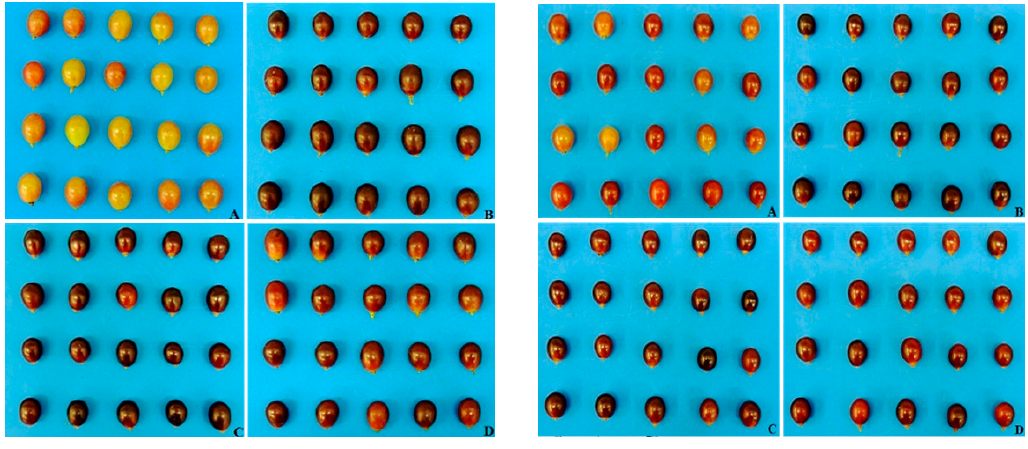
Figure 3. Berries of ‘Benitaka’ table grapes subjected to different treatments with ( S )- cis -abscisic acid ( S -ABA 400 mg L − 1 ). A : control (no application); B : at pre-veraison; C : at veraison; D : at